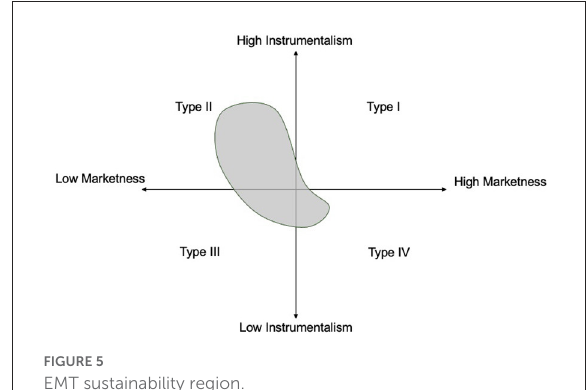
FIGURE5 EMT sustainability